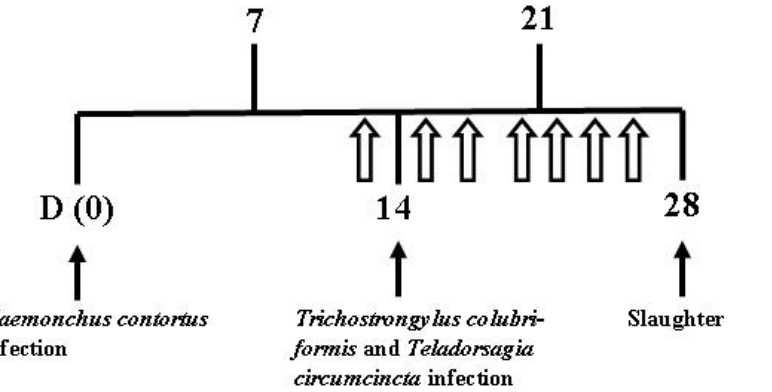
Figure 1. Timeline for lambs ( n = 16) infected with Haemonchus contortus, Trichostrongylus colu- briformis, and Teladorsagia circumcincta and dosed loline/fecal sampled .